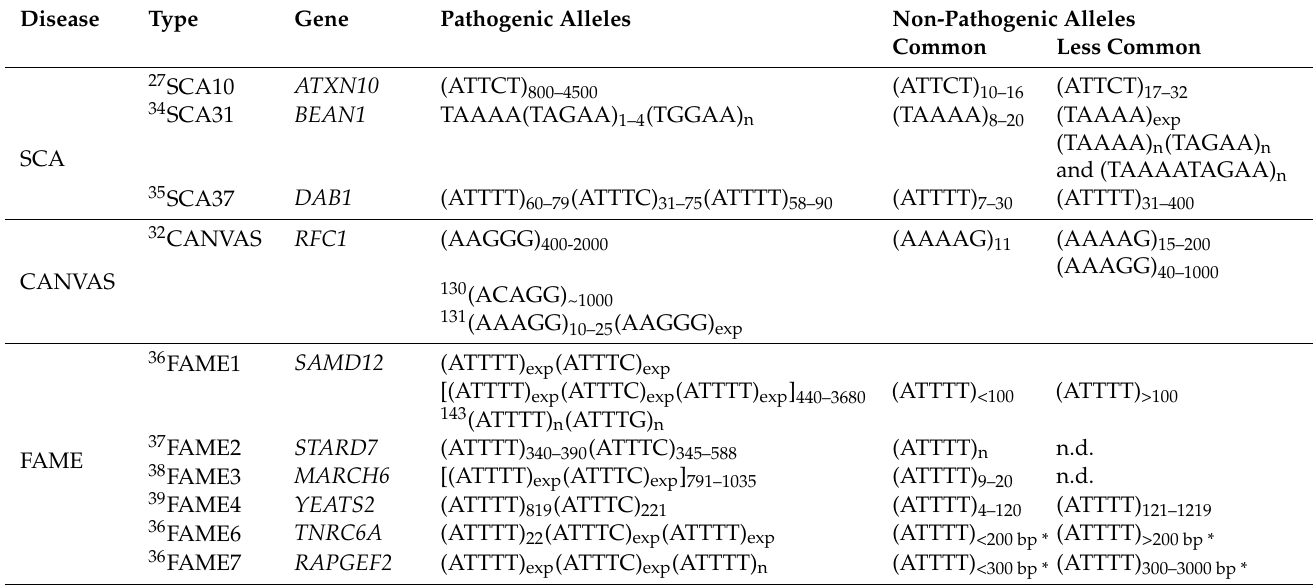
Table 1. Neurological diseases caused by pentanucleotide repeat